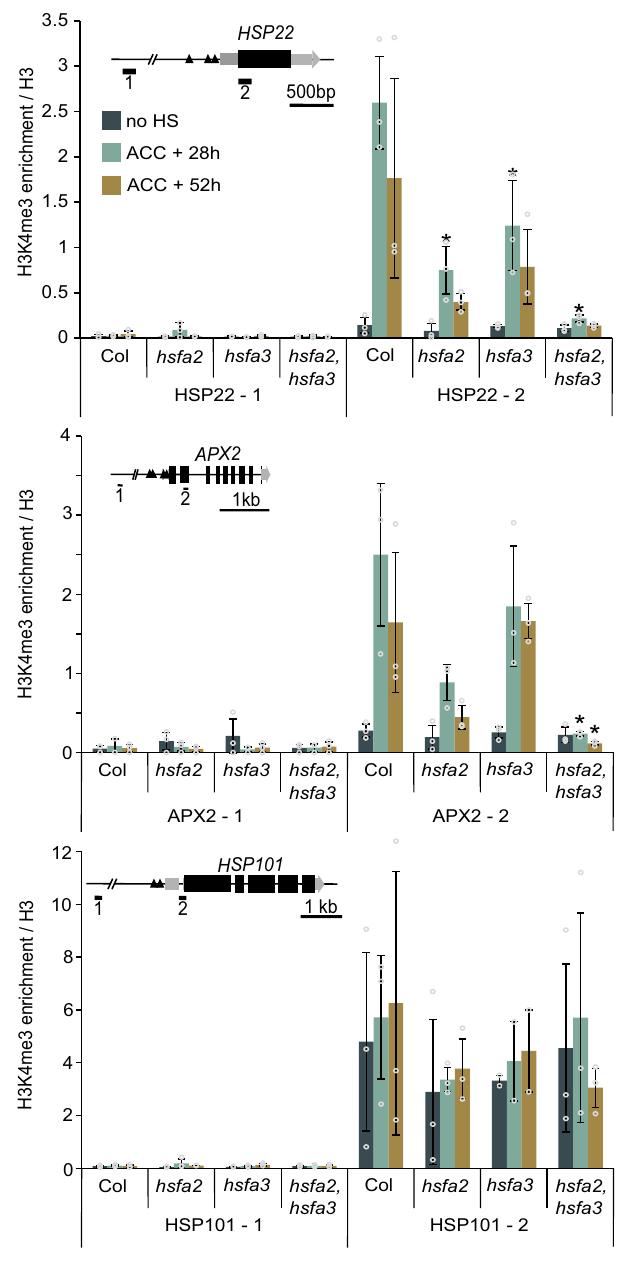
Fig. 9 H3K4me3 deposition depends on HSFA2 and HSFA3. Enrichment of H3K4me3 over H3 for the HS memory genes HSP22 and APX2 , and the non-memory gene HSP101 as determined by ChIP-qPCR from three independent experiments. For each locus one control amplicon situated approximately 3 kb upstream is shown alongside the amplicon covering the transcriptional start site (inset gene models). Time points are given in h after end of ACC treatment. Data are mean ± SD. Asterisks mark signi fi cant differences relative to Col ( p < 0.05, unpaired two-sided